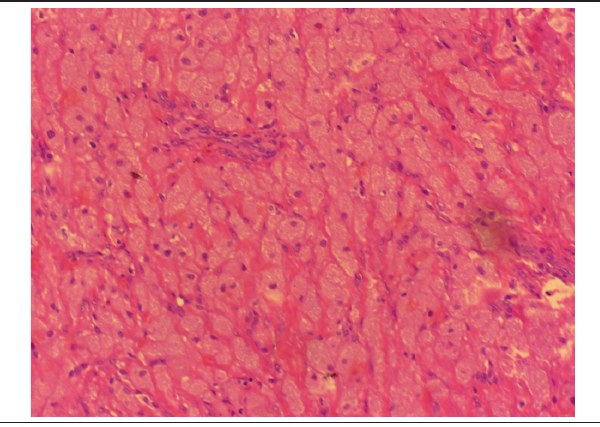
fIgura 3 – TCG, HE,